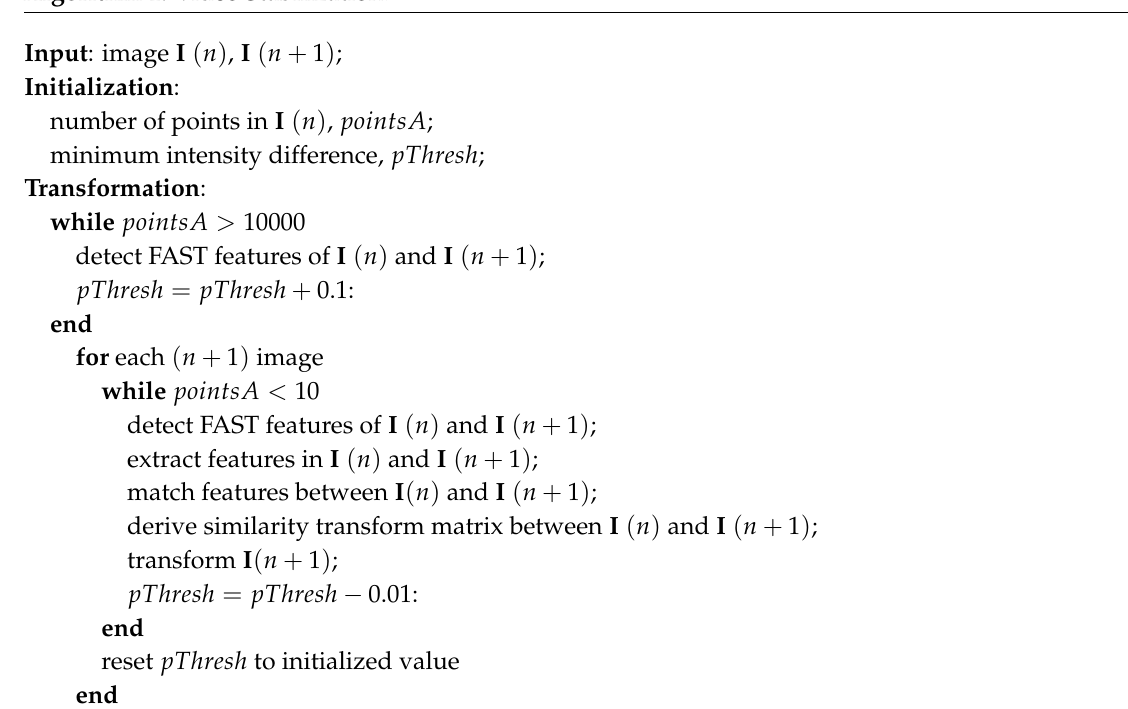
Algorithm 1. Video